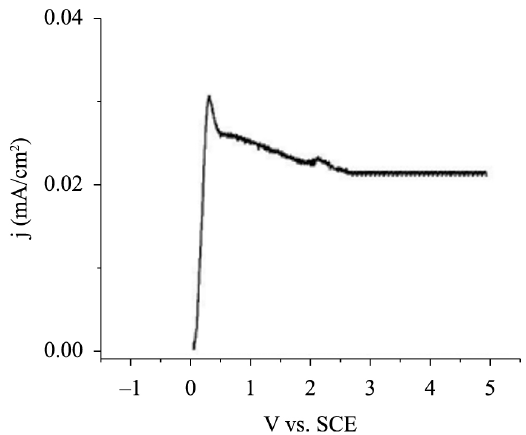
Figure 3. Potential sweep profile for tantalum oxide obtained up to 5 V (50 mV/s) in H